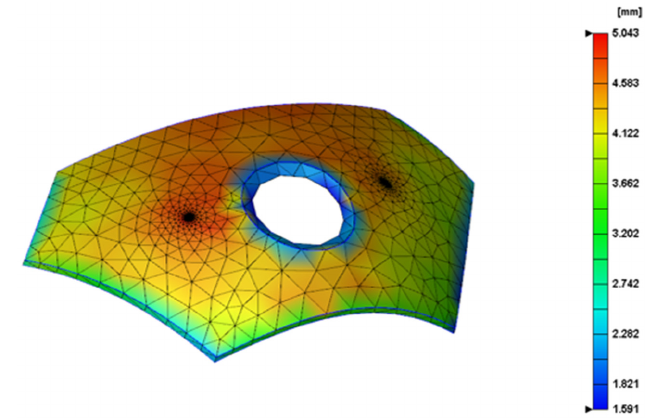
Figure 3. Peek material armor thickness distribution map.